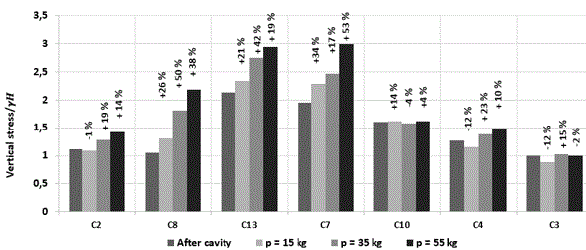
Figure 8. Evolution of the vertical stress during loading – granular